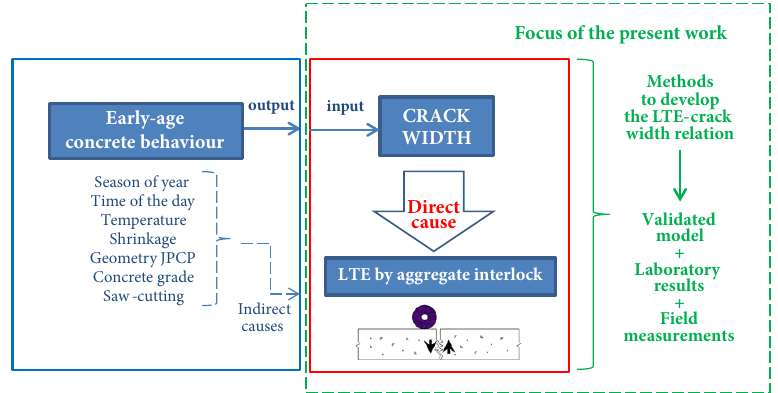
Season of year Time of the